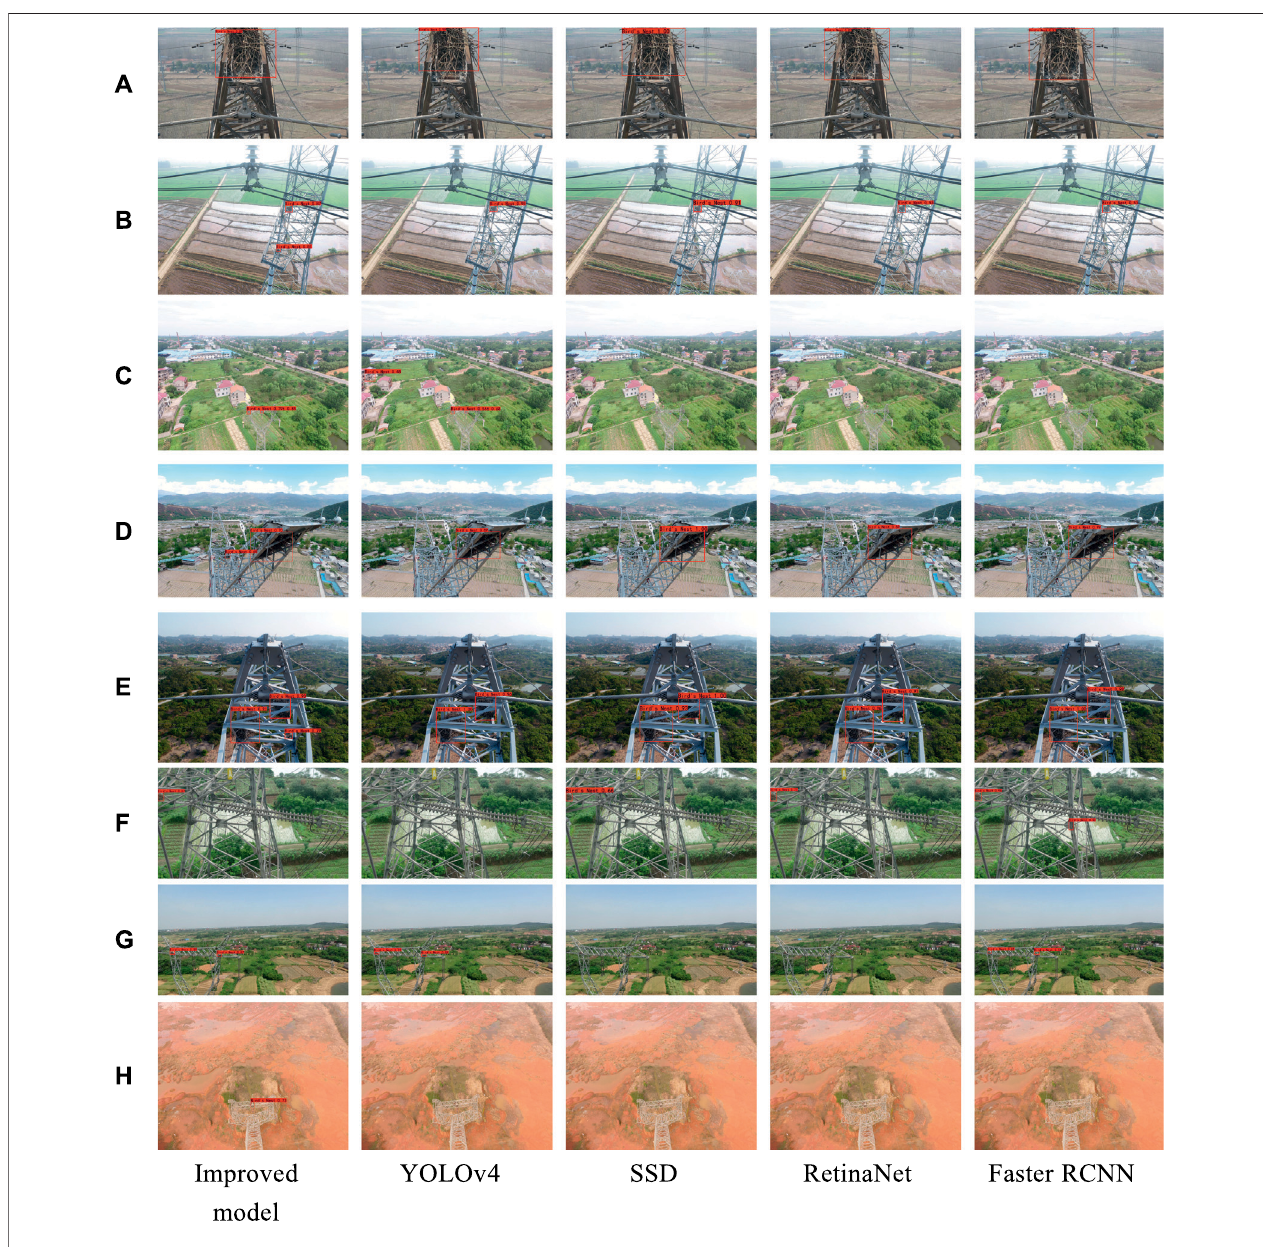
FIGURE 8 | Test results of different detection